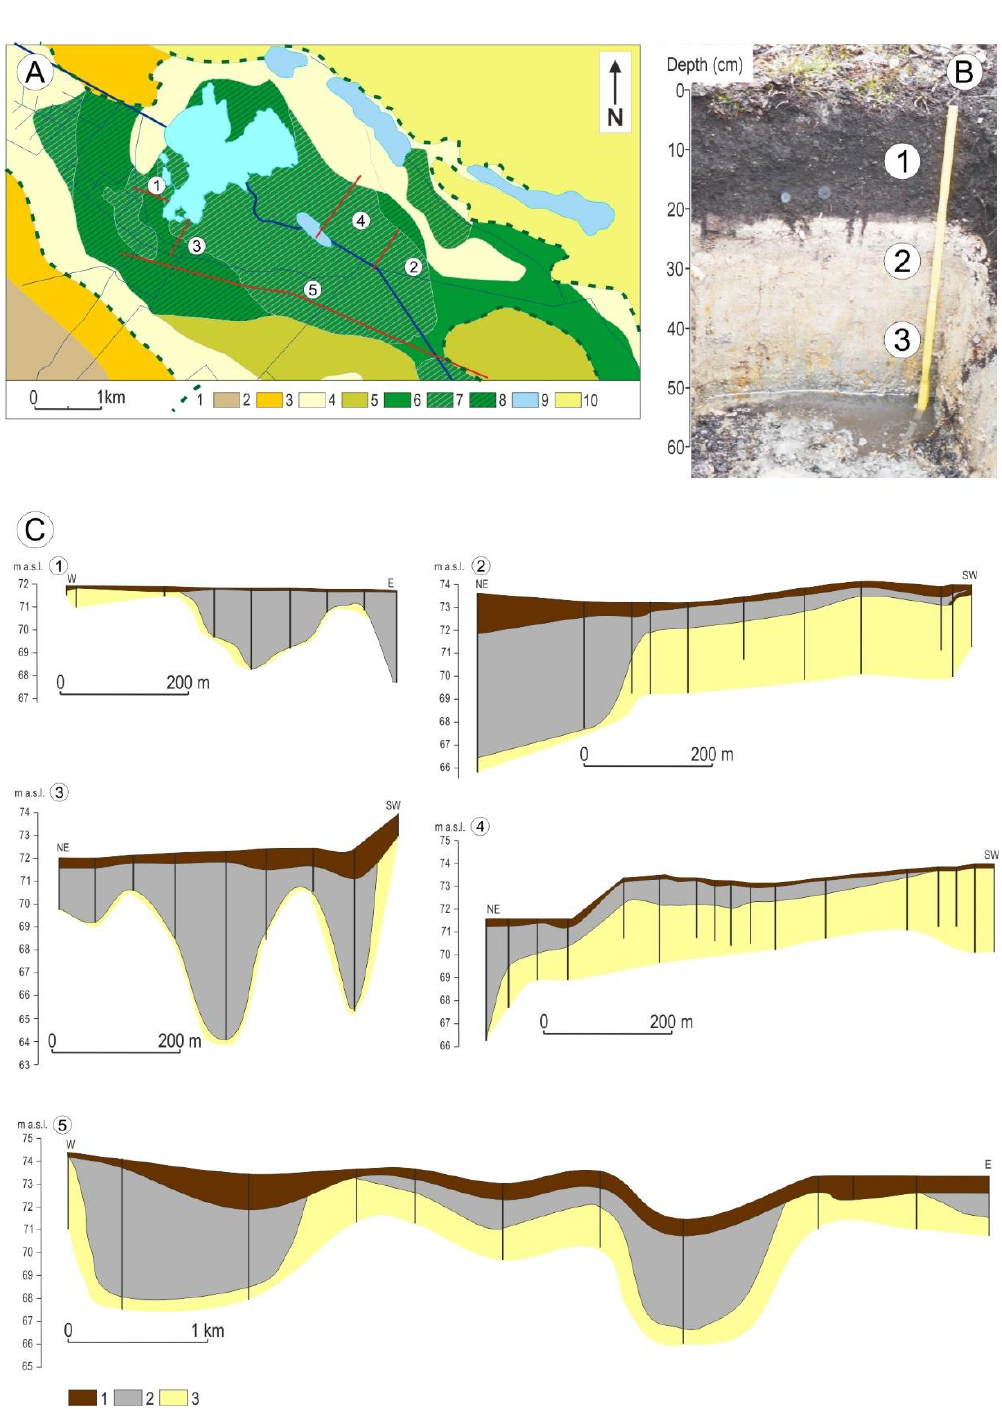
Figure 3. Geological structure: ( A ) Geological map (based on field work and Geological Map of Poland 1:50,000) 1. The range of biogenic sediment and lake sand 2. Clay, 3. Fluvio–glacial sands, 4. Lake sands, 5. Muds, 6. Peat, 7. Peat on Gyttja, 8. Peat on sands, 9. Gyttja, 10. Water, 11. Aeolian sands; ( B ) Soil profile photo 1. Decomposed peat, 2. Calcareous gyttja, CaCO 3 —70%, mineral matter 30%, 3. Silty sands; ( C ) Geological cross-sections 1. Decomposed peat, 2. Calcareous Gyttja, 3. Silty